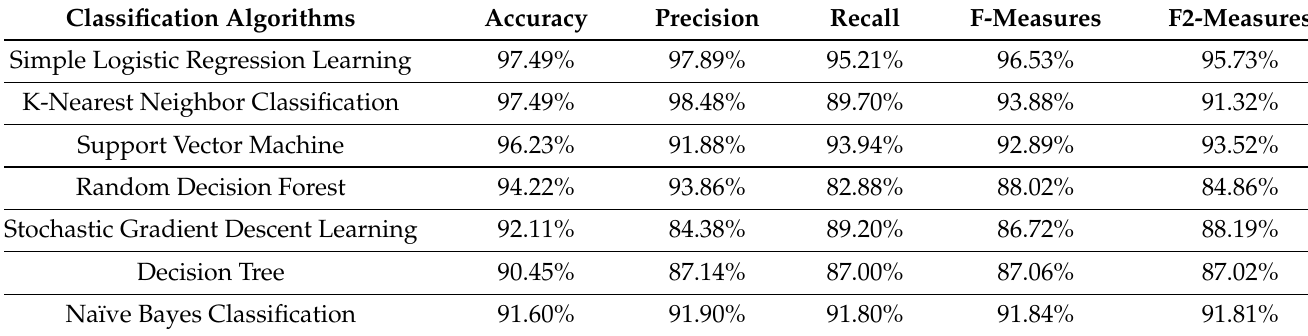
Table 2. Comparison of different classification methods on WBCD after feature scaling, and hyper-parameter tuning of features using PCA and correlation